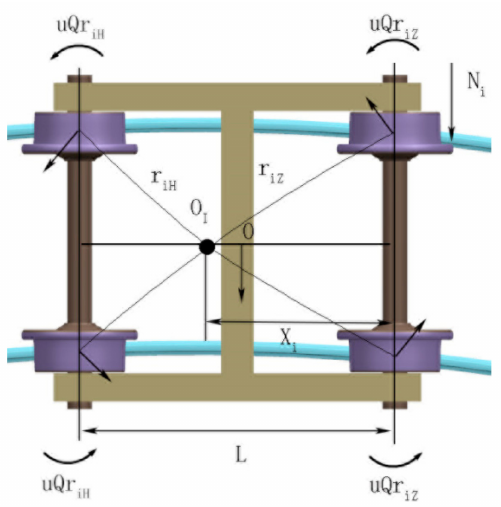
Figure 2. Schematic of the dynamically free-inscribing